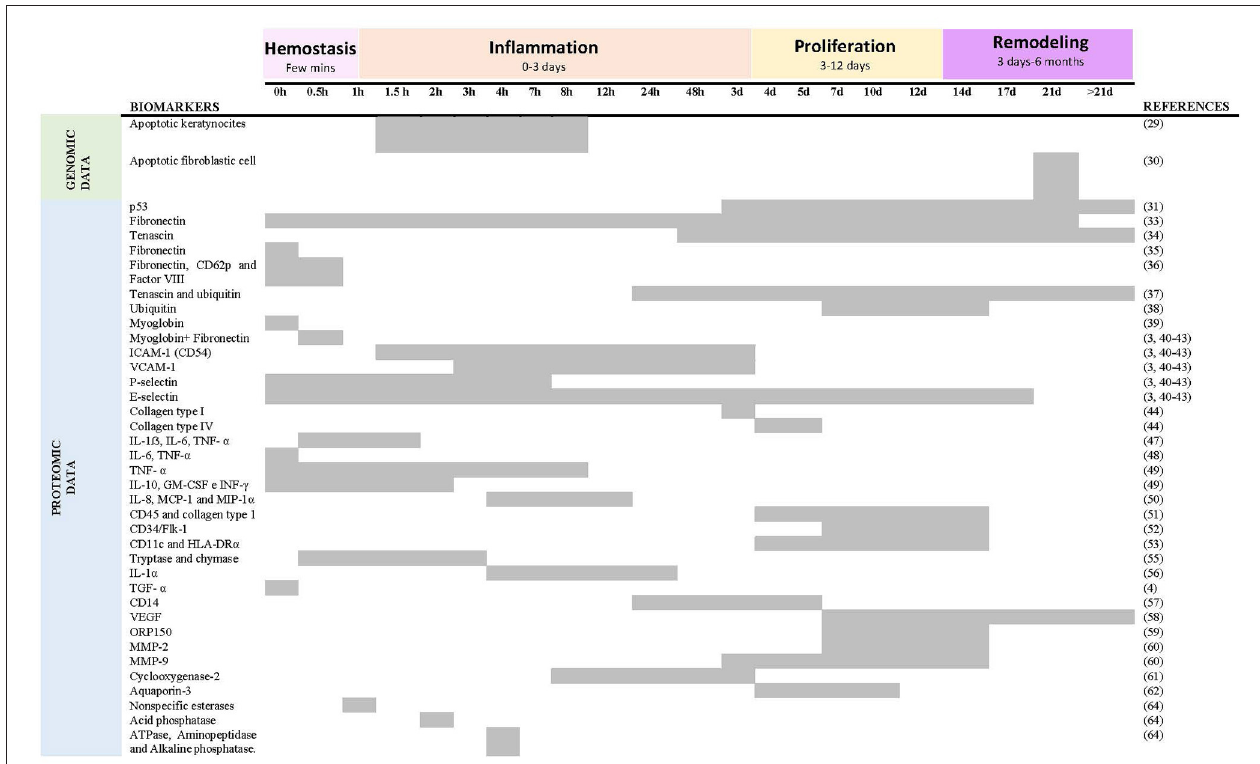
FIGURE 4 | Summary of reactivity of age biomarkers respect to time after skin injury. Five studies (31, 44, 45, 53, 62) were excluded because they do not place the appearance and/or quantification of a marker on a timeline about the age of the